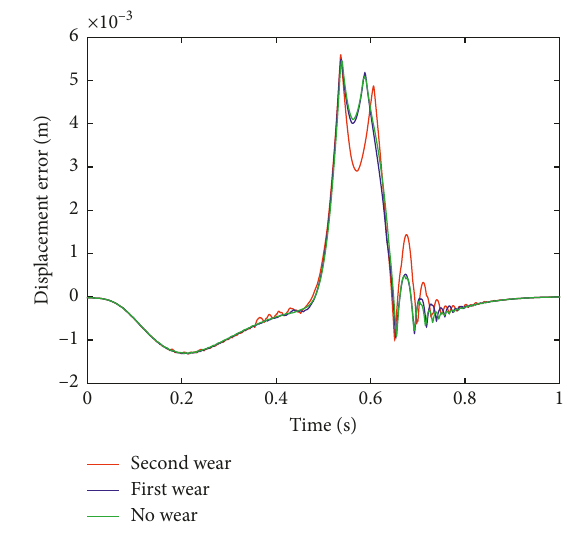
Figure 16: Slider’s displacement error.